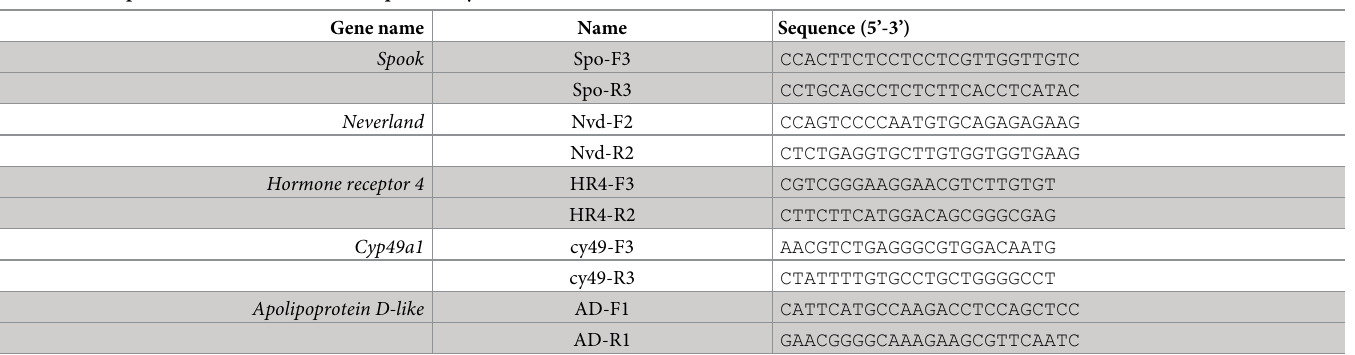
Table 2. List of primers that were used for the qPCR